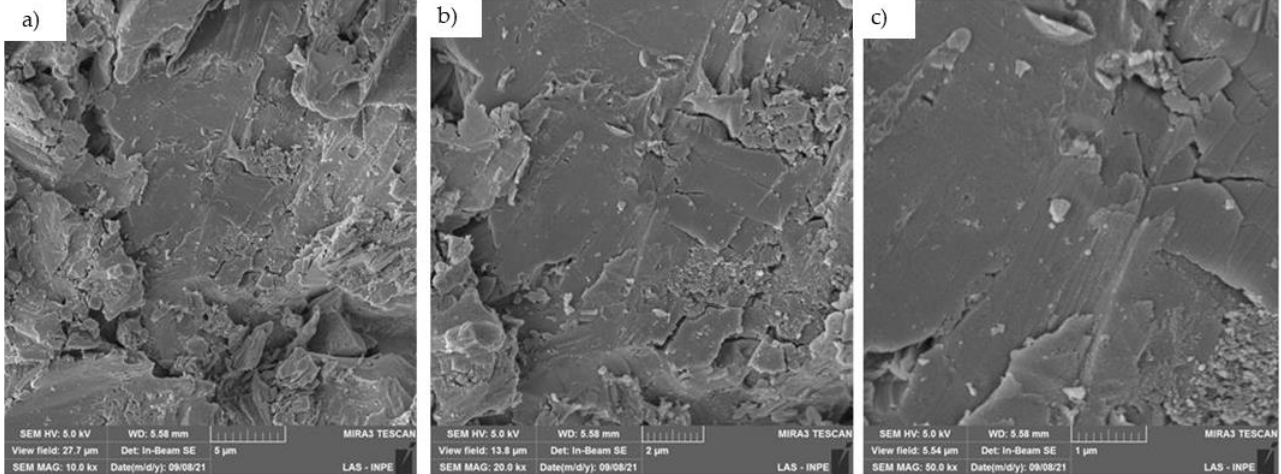
Figure 8. Micrographs of representative samples of the implants at ( a ) 20,000 × , ( b ) 50,000 × , and ( c ) 100,000 × magnification.